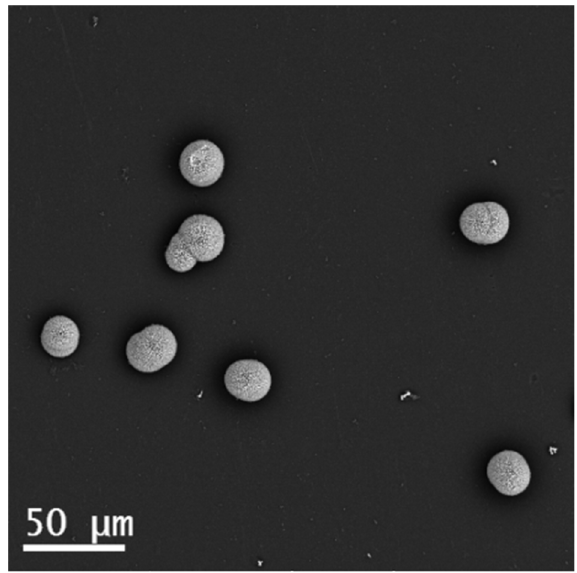
Figure 7. Spherulitic structures obtained from gas diffusion experiments for BaCO 3 precipitates in presence of PA [0.1 M].